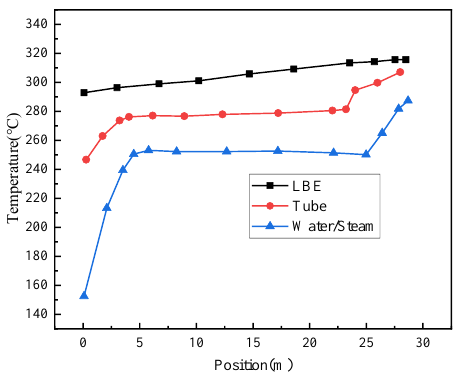
Figure 3. Temperature distribution of OTSG in Ref. [28].